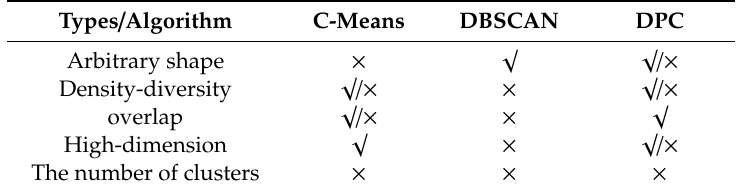
Table 1. Applicable range of typical clustering algorithms. Table 1 . Applicable range of typical clustering algorithms.